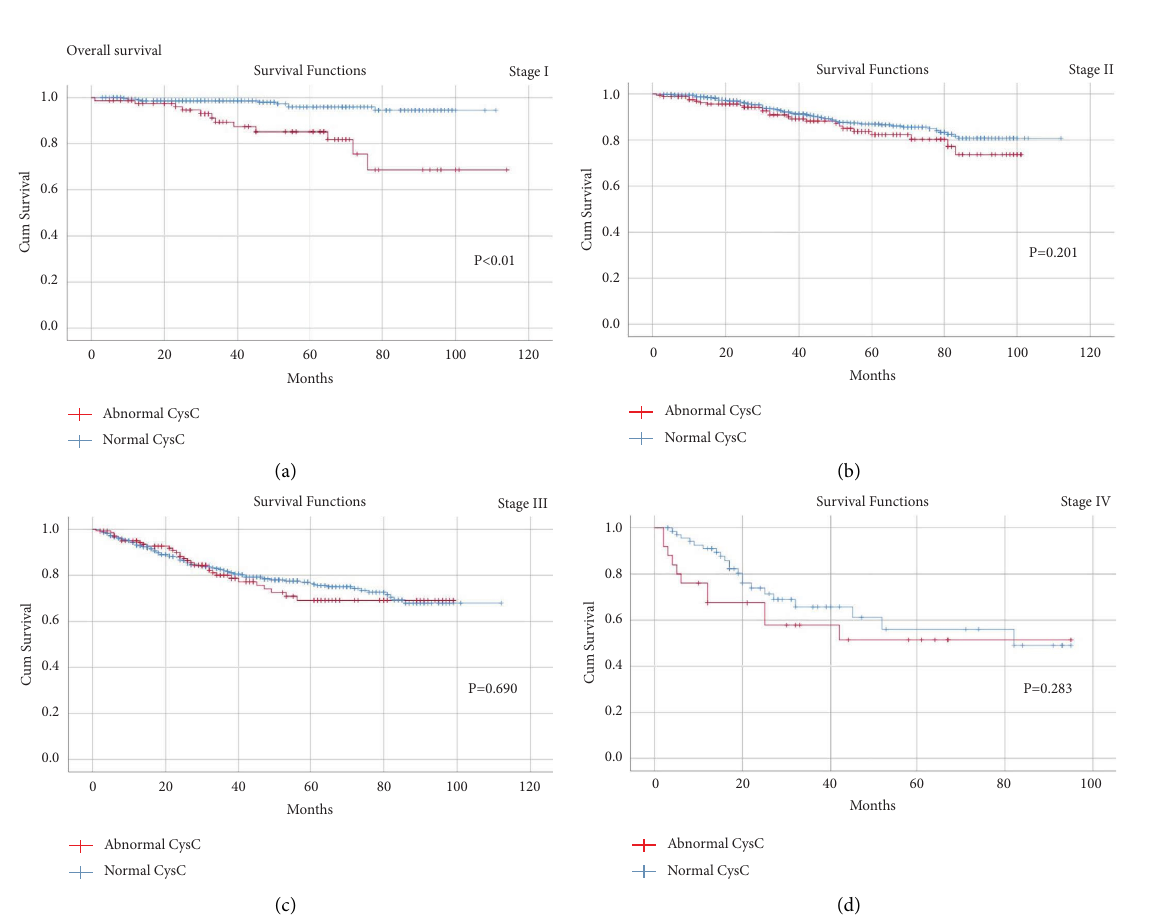
Figure 2: Kaplan − Meier survival curve for the impact of preoperative CysC on the overall survival of patients in TNM stages